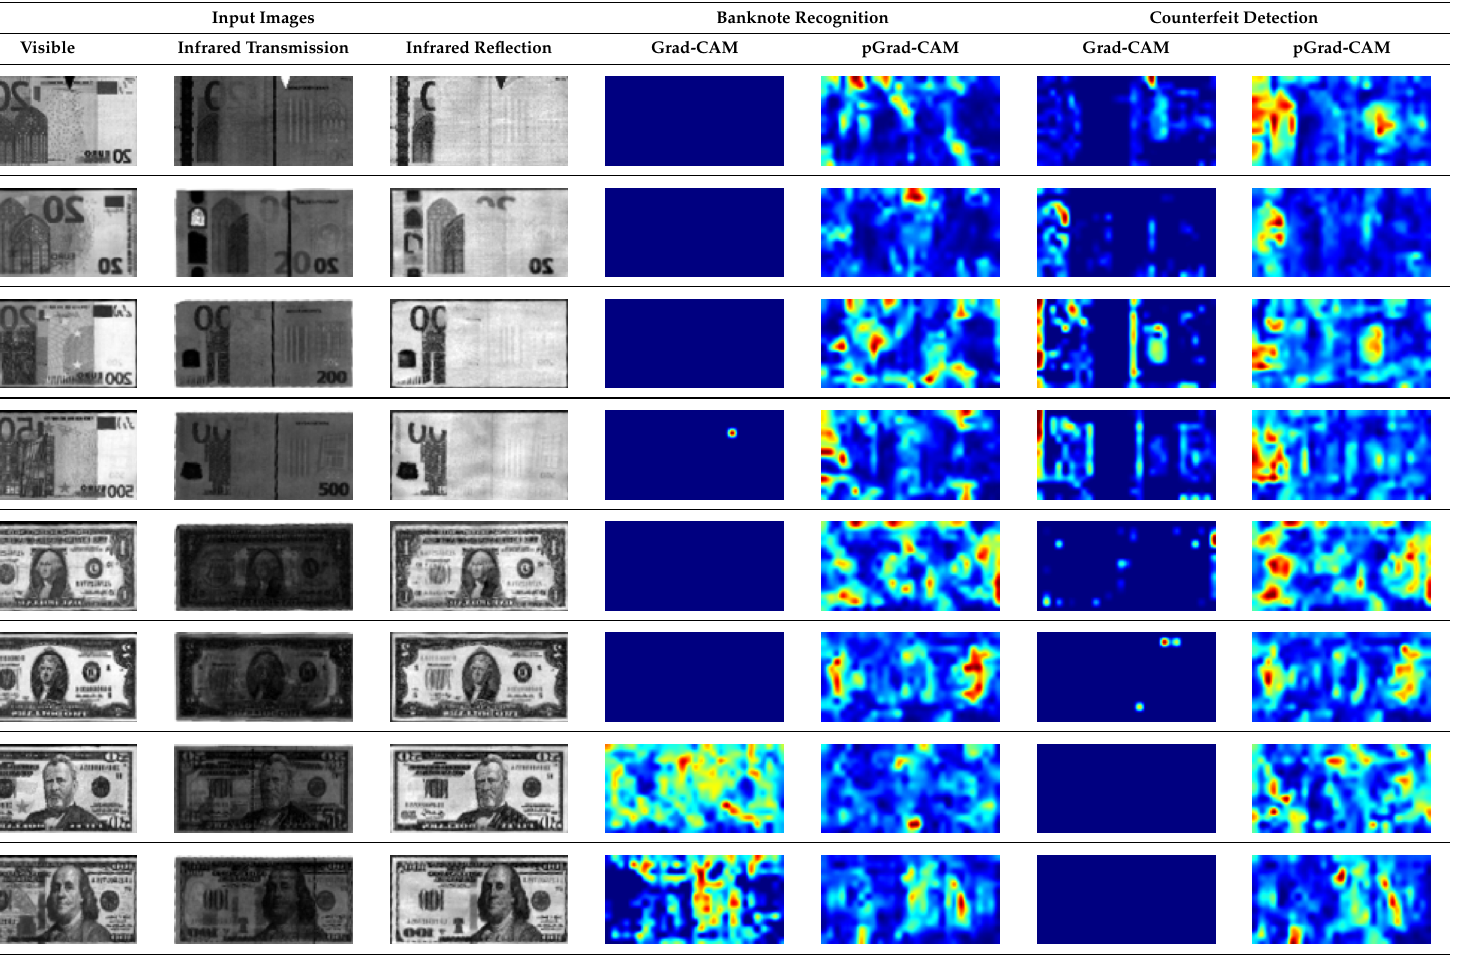
Table 5. Grad-CAM and pGrad-CAM